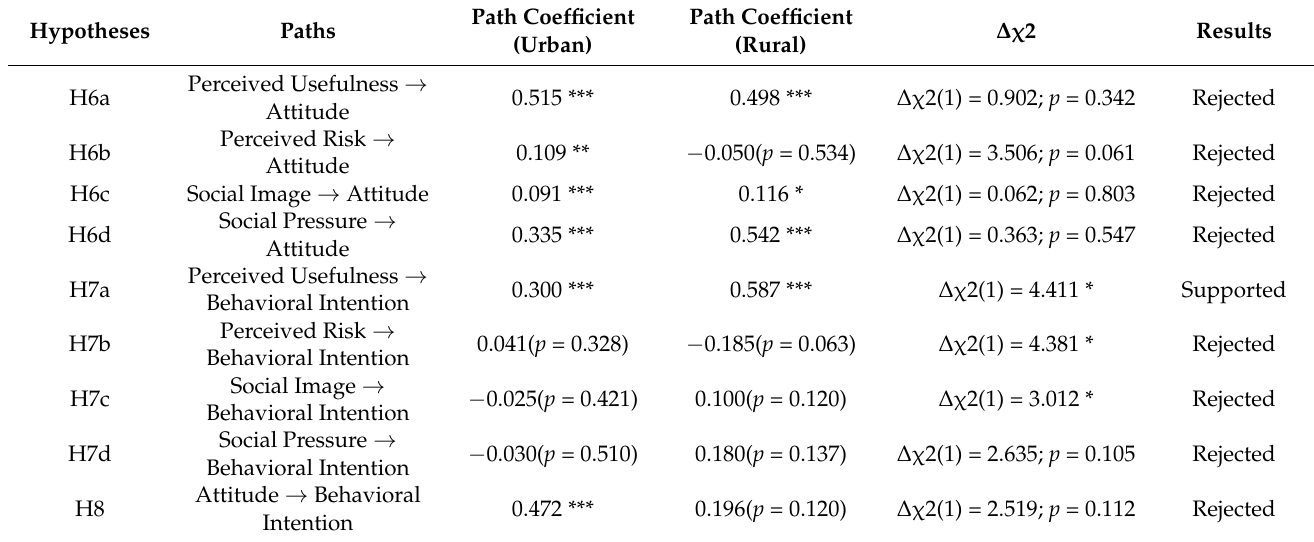
Table 6. Results of Multi-group